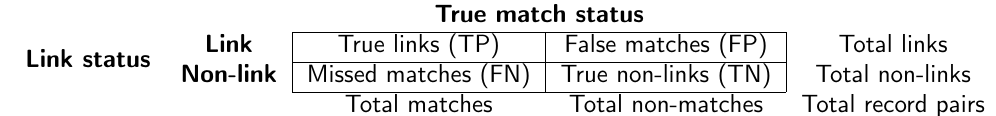
Figure 1: Classification diagram of record linkage outcomes against true match status